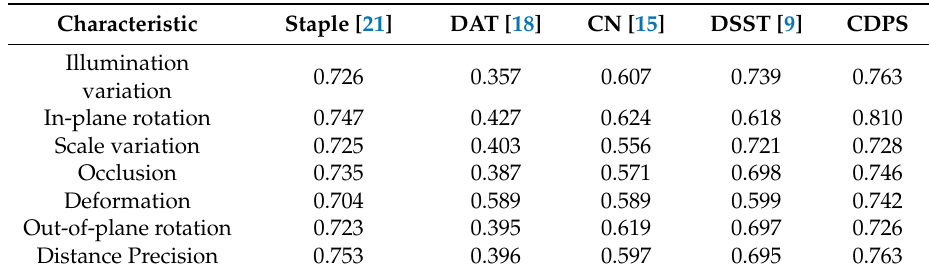
Table 3. Precision rates of the different methods.